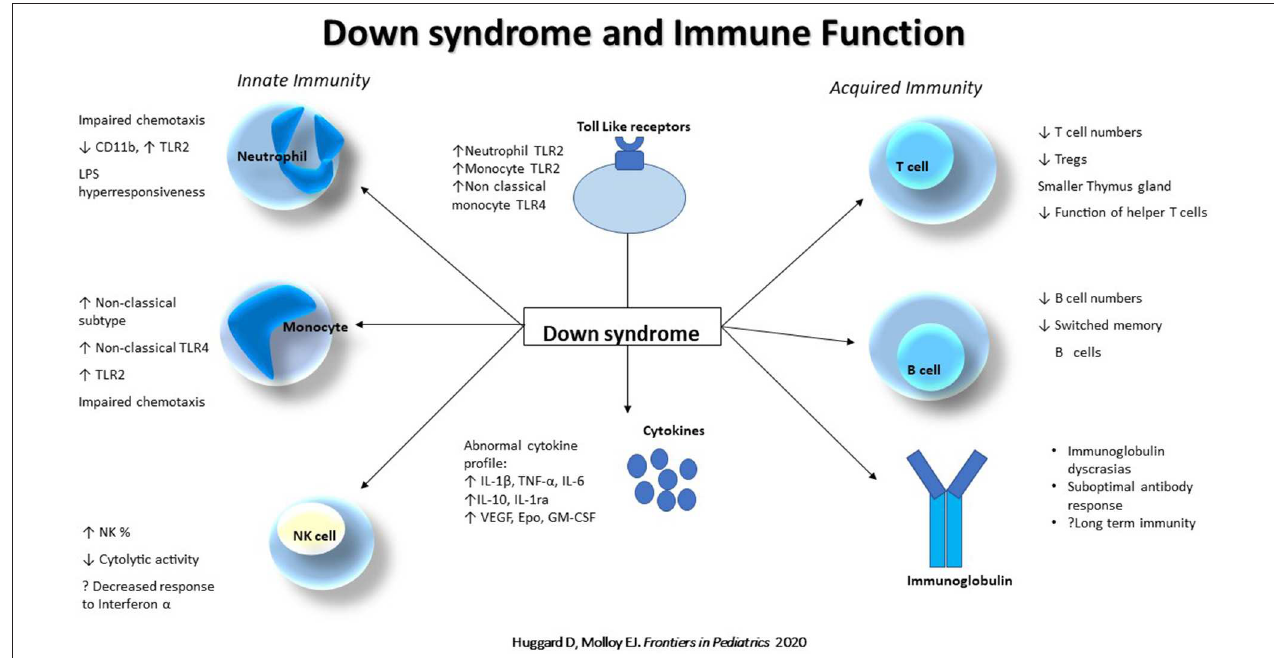
FIGURE 1 | Down syndrome and immune function. Abnormalities of the innate (Neutrophil, Monocyte and Natural killer cell) and acquired (T and B cell, and immunoglobulins) immune system in Down syndrome. NK, Natural Killer cell; TLR, Toll like receptor; TNF, Tumor necrosis factor; Tregs, Regulatory T cells.